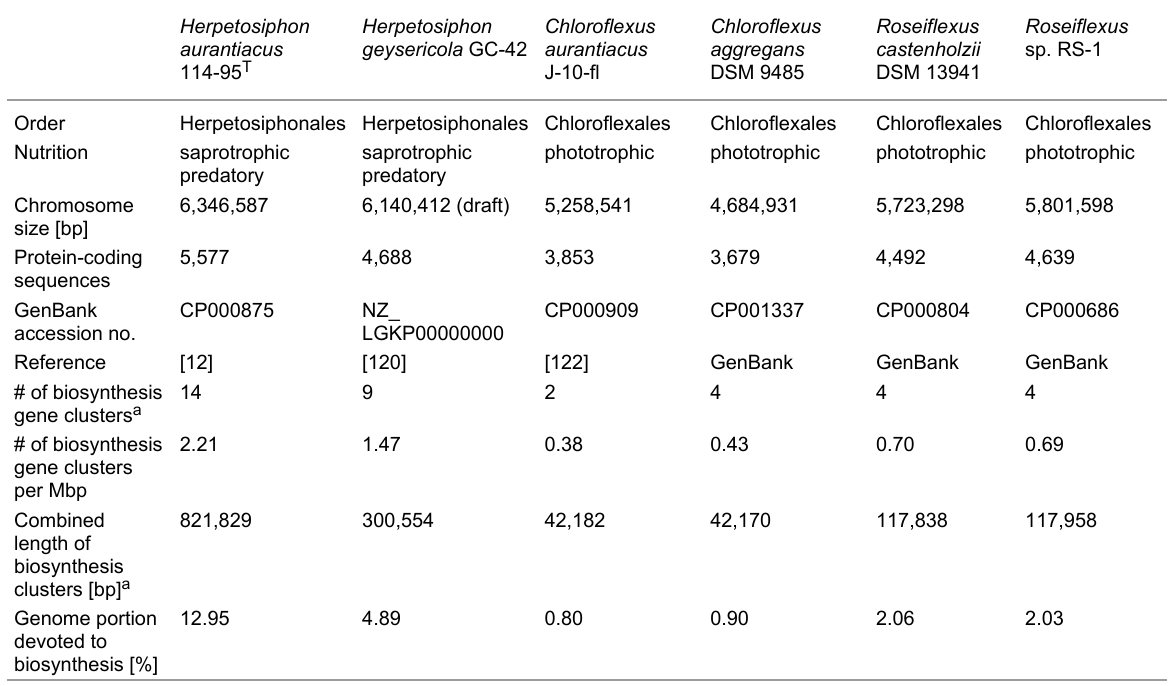
Table 3: Taxonomic assignment, nutrition, genomic and biosynthetic features of Chloroflexi